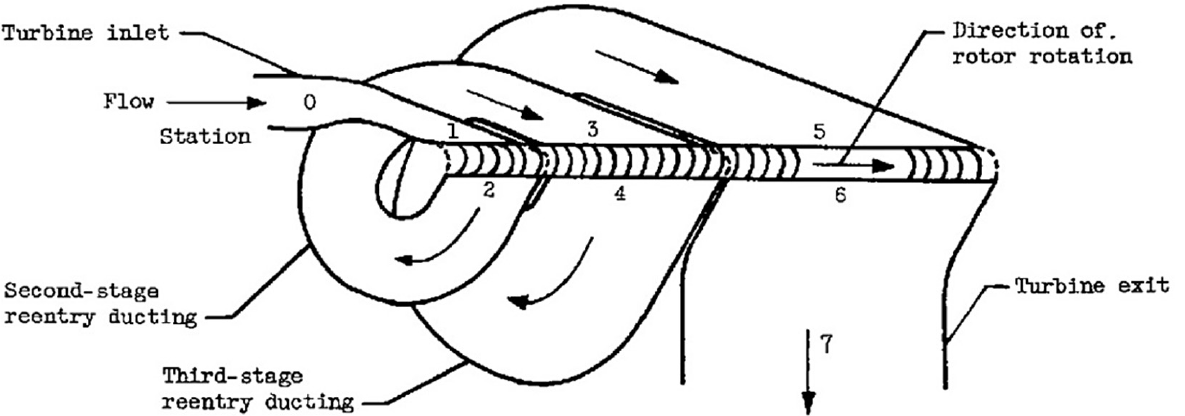
Figure 2. Axial velocity compounded re-entry turbine by Evans et al. [10] with 3 velocity stages (0 nozzle, 1 inlet first wheel pass, 2 outlet first wheel pass, 3 inlet second wheel pass, 4 outlet second wheel pass, 5 inlet third wheel pass, 6 outlet third wheel pass, and 7 turbine outlet).